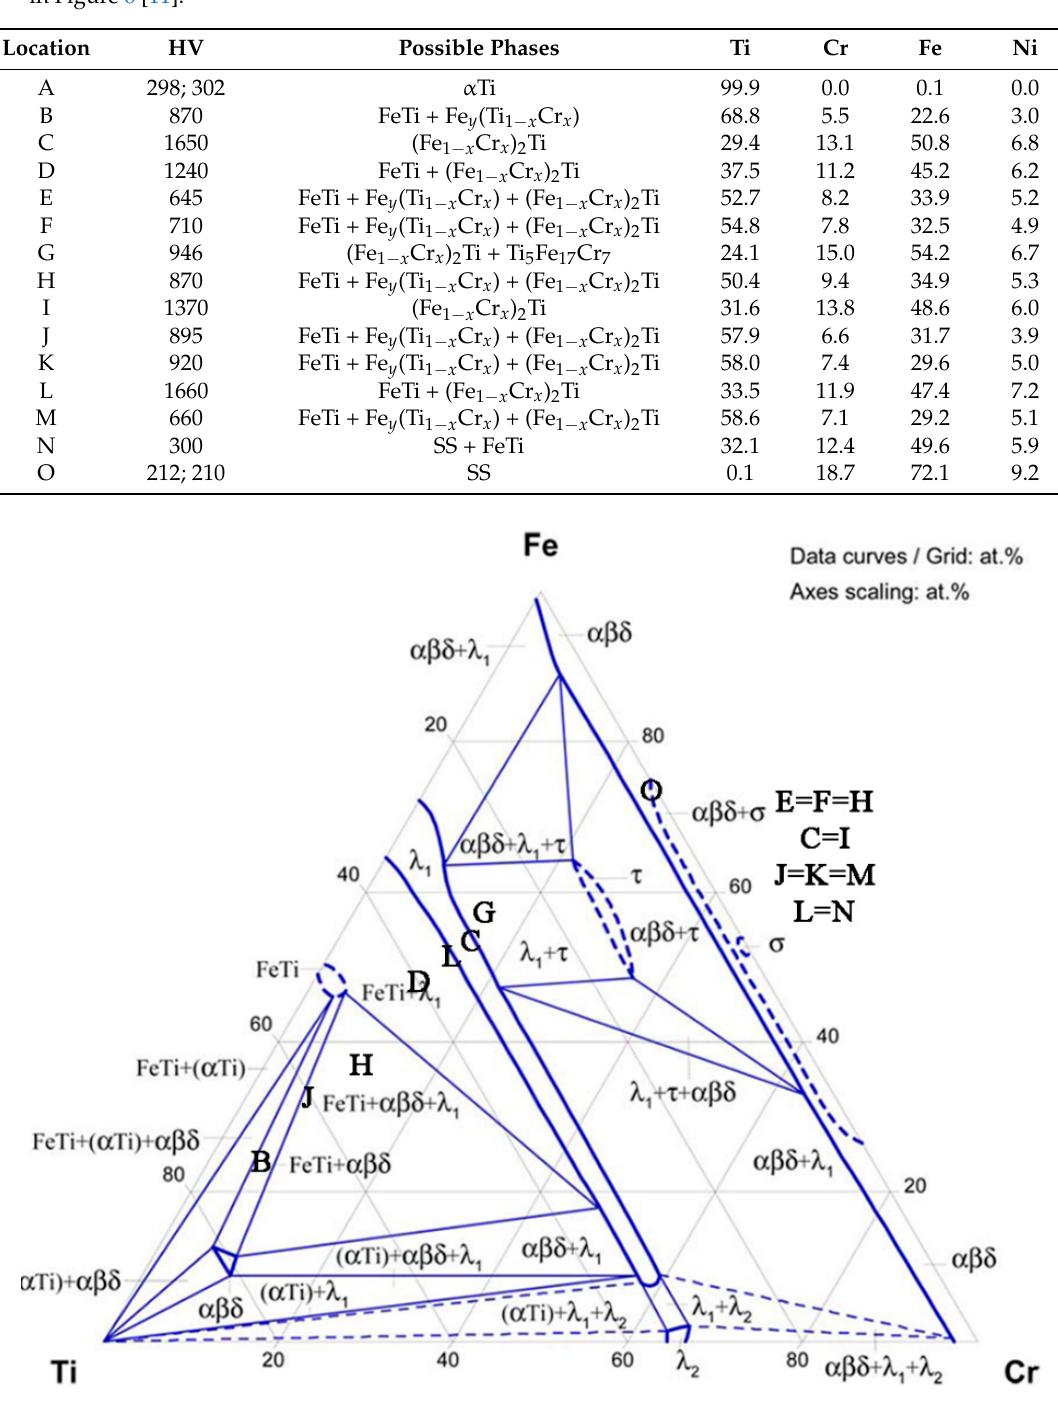
Figure 6. Isothermal (550 °C) ternary phase diagram of Fe-Cr-Ti adapted from [11] where labels B-O correspond to the positions in Figure 3.